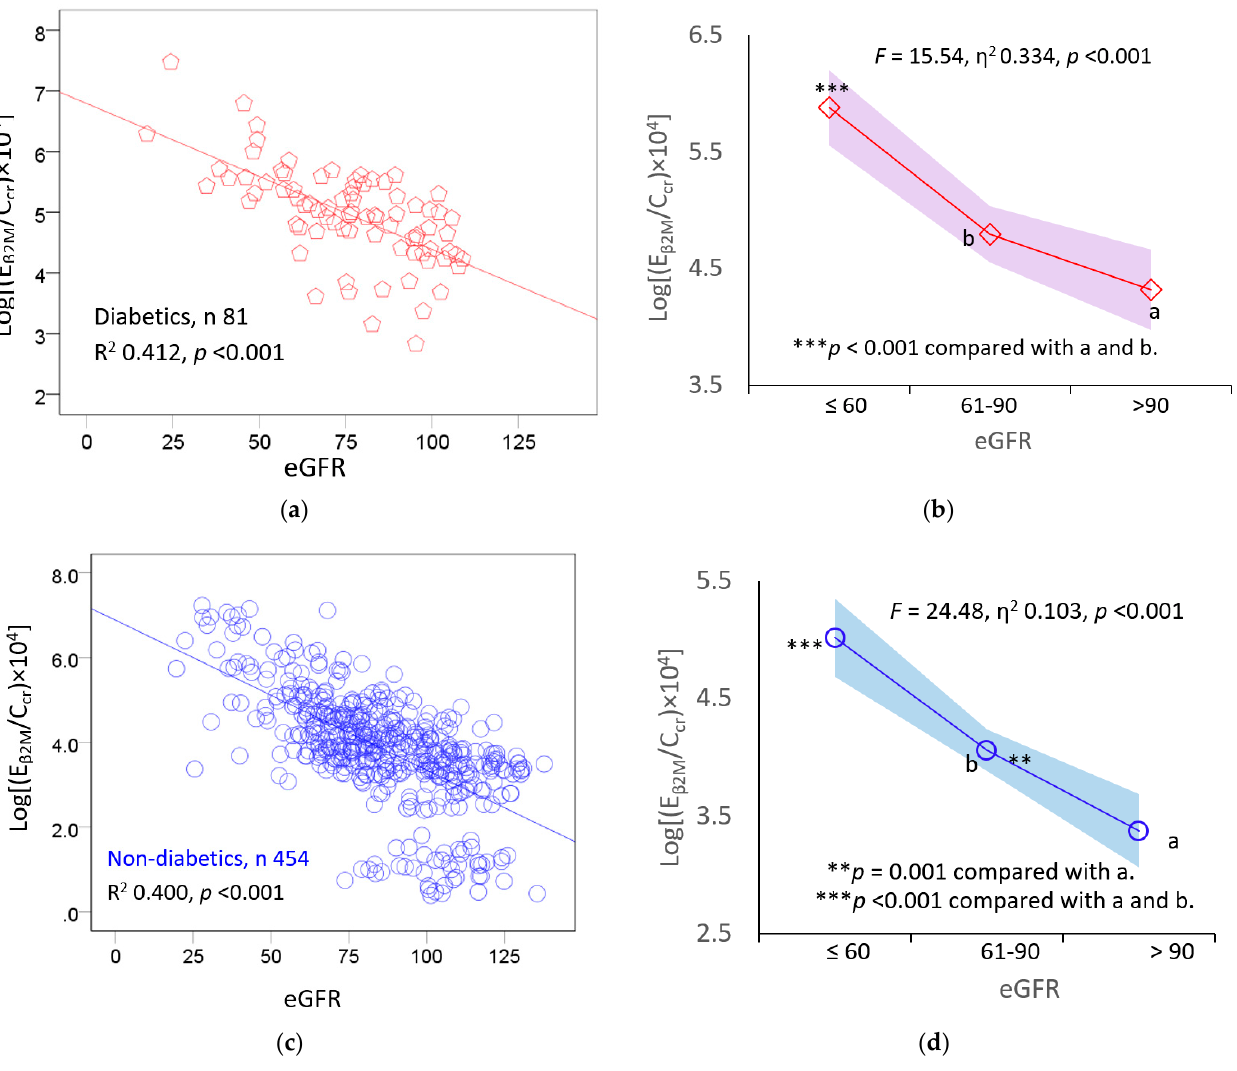
Figure 2. Excretion rates of β 2 M in relation to eGFR reduction. Sca tt erplot ( a ) relates log[(E β 2M /C cr ) × 10 4 ] to eGFR in all diabetics. Graph ( b ) depicts mean log[(E β 2M /C cr ) × 10 4 ] and the variability of each mean in diabetics grouped by ranges of eGFR. Sca tt erplot ( c ) relates log[(E β 2M /C cr ) × 10 4 ] to eGFR among non-diabetics. Graph ( d ) depicts mean log[(E β 2M /C cr ) × 10 4 ] and the variability of each mean in diabetics grouped by ranges of eGFR. Coe ffi cients of determination (R 2 ) and p -values are provided for all sca tt erplots. Mean values were adjusted for covariates and interactions. Unit of E β 2M /C cr is µg/L of fi ltrate, and the unit of eGFR is mL/min/1.73m 2 .